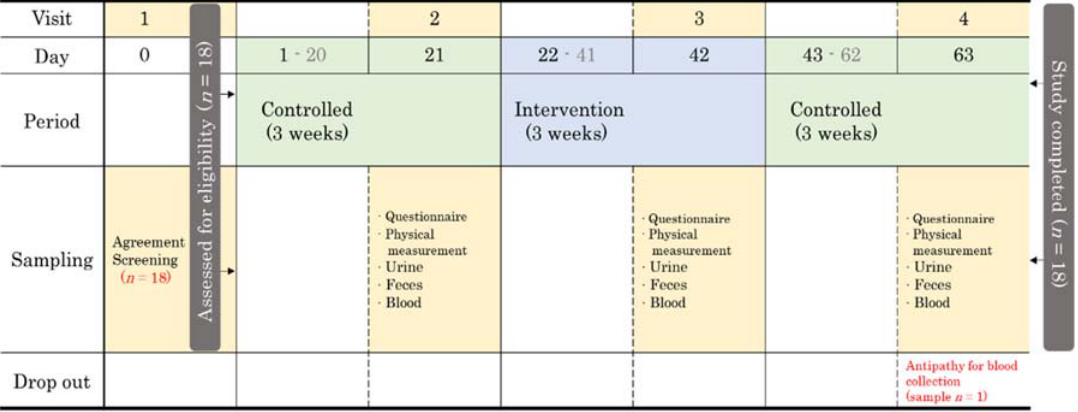
Figure 1. Schematic of the study design and flow.